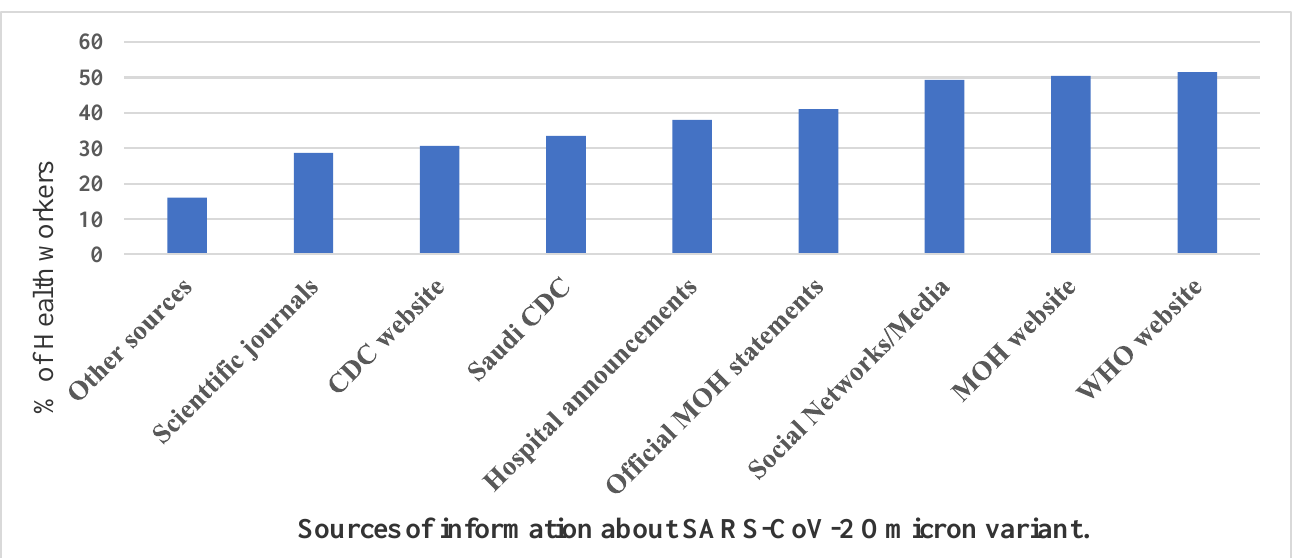
Figure 1. The HCWs’ used sources of information on the Omicron variant.